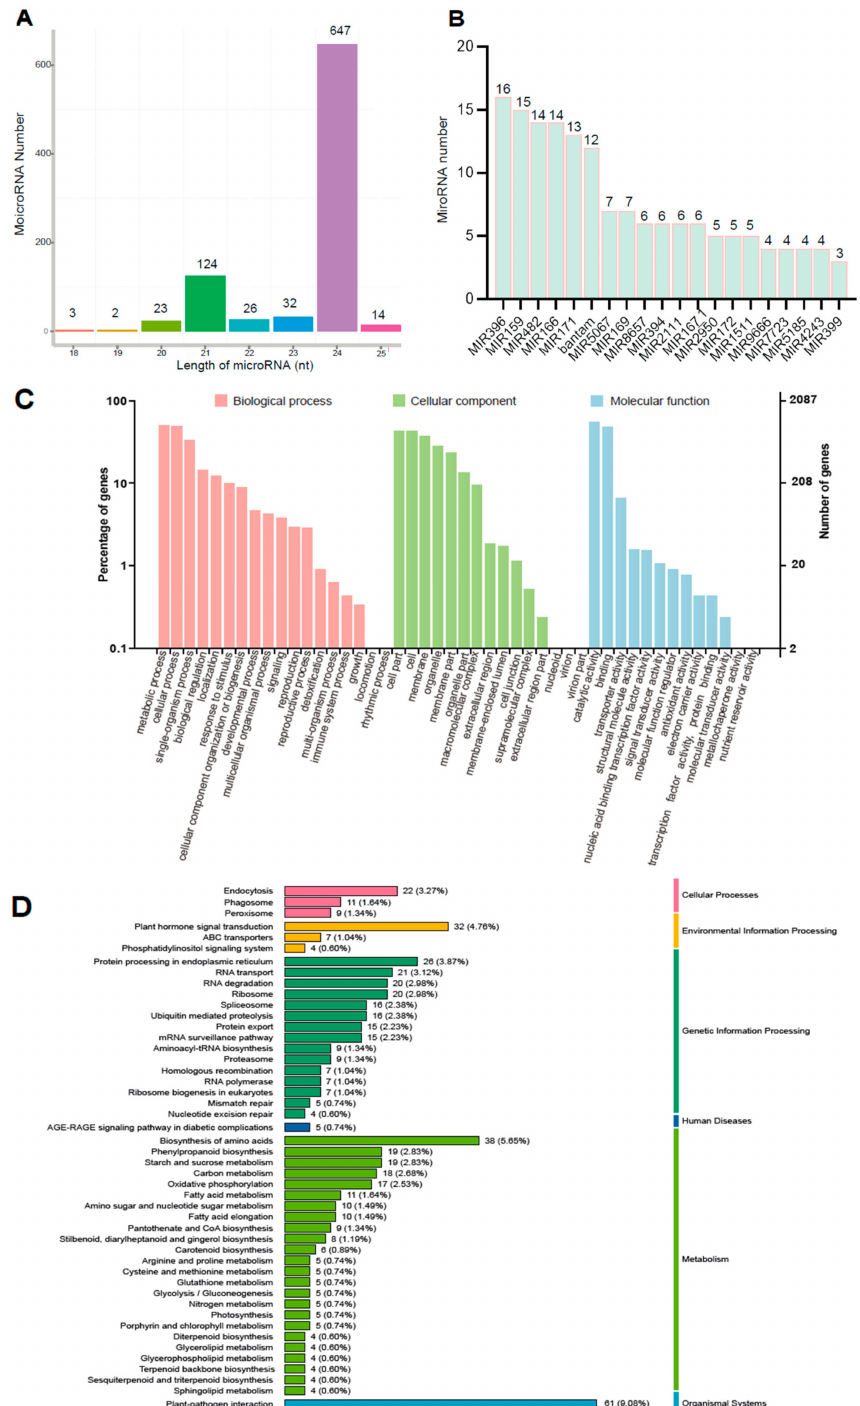
Figure 2. Structural variation in miRNAs and annotation of their target genes detected in C. burmannii leaves. ( A ) Length distribution of novel miRNAs detected via sRNA sequencing. ( B ) Numbers of miRNAs assigned to different families listed in descending order. ( C ) Functional annotation of 1997 target genes based on gene ontology (GO) categories. ( D ) Functional annotation of the target genes based on the Kyoto Encyclopedia of Genes and Genomes (KEGG)